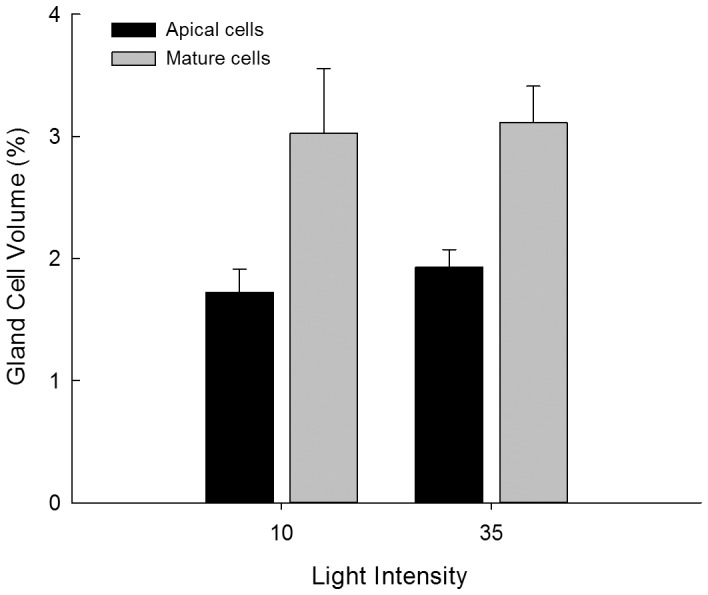
Empirical means of the percent volume (+1 SE) of the algal filament that is occupied by gland cells for apical and mature cells along the axis.Results represent the combined treatments for algae cultured under 10 µmol photons m−2 s−1 and 35 µmol photons m−2 s−1. N = 10 individuals per treatment.